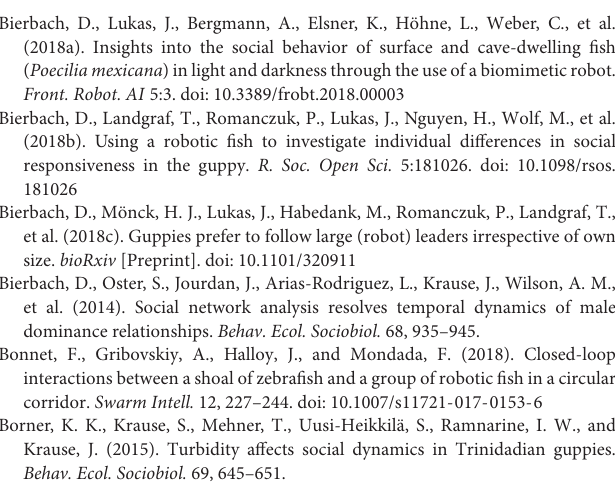
FIGURE S1 | Photograph of differently-sized replicas. Left (20 mm SL) and middle (25 mm SL) replicas are unprocessed 3D printed blanks that were later on equipped with glass eyes and color-painted as shown for the 30 mm replica on the right. FIGURE S2 | Speed distributions during a trial (a) as well as speed profiles (b) of the three differently-sized replicas. In (a) fraction of speeds with a 1 cm/s bin size are shown for a trial run (60 s). There was no significant difference among replicas (Kolmogorov-Smirnoff test: P > 0.41). In (b) the speed profiles of Robofish with all three replicas are shown. There was no significant difference in accelerating/ decelerating among replicas (Kolmogorov-Smirnoff test: P > 0.99). Please note that this pattern of acceleration and deceleration is typically found between two turning points along the zig-zag movement. Maximum speed was set to 15 cm/s (dashed